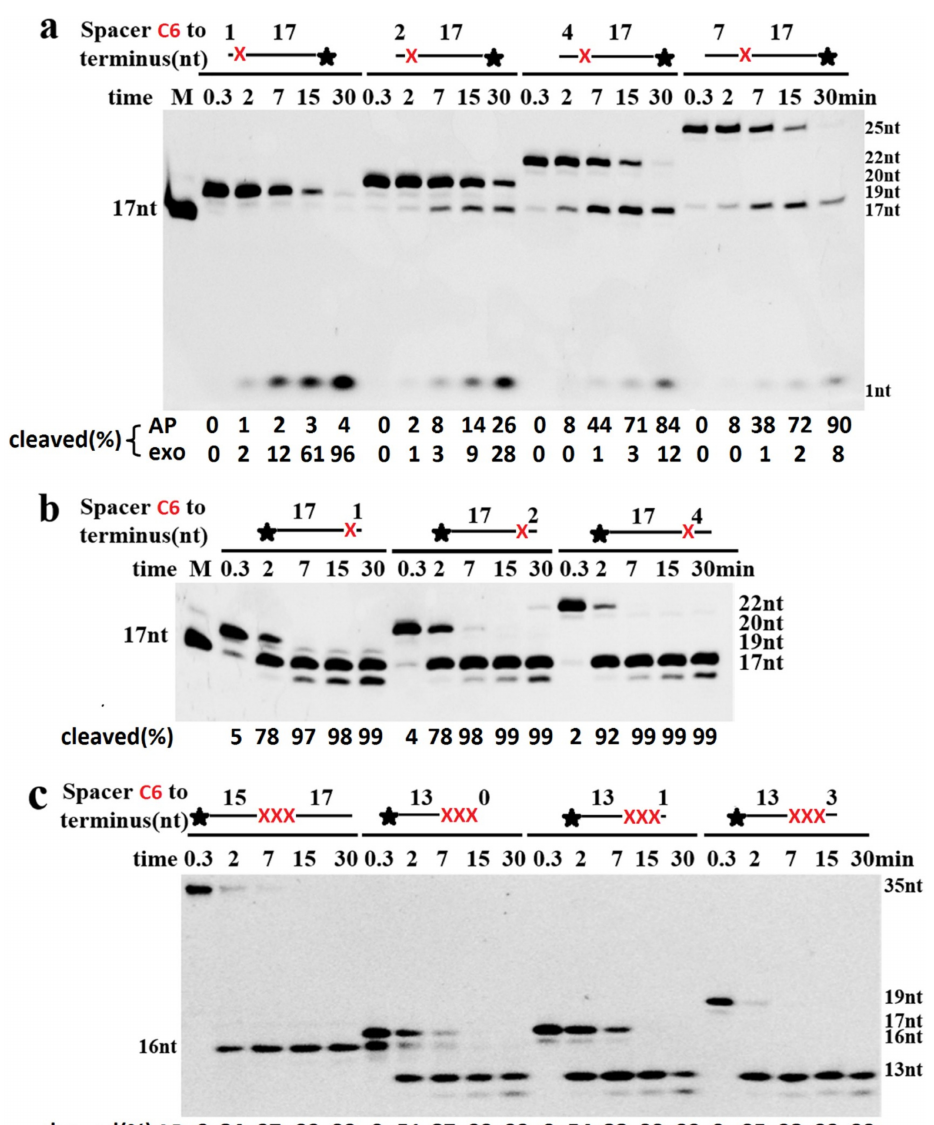
Figure 6. Cleavage of ssDNAs with a Spacer near the 3 (cid:48) -/5 (cid:48) -terminus. TeuendoIV (5 nM) was incubated with 100 nM ssDNA containing one Spacer C6 adjacent to the ( a ) 5 (cid:48) -terminus, ( b ) 3 (cid:48) -terminus, or ( c ) three Spacers (Spacer C6) adjacent to the 3 (cid:48) -terminus at 55 ◦ C for the indicated time. Uppercase letter M denotes oligonucleotides marker. The cleavage percentages of substrates are listed at the bottom of each panel. AP denotes AP endonuclease activity and exo denotes 3 (cid:48) -exonuclease activity. The symbol of black asterisk and the red letter X denote the fluorescein (6-FAM) group at the 5 (cid:48) - or 3’-end and the AP-site,